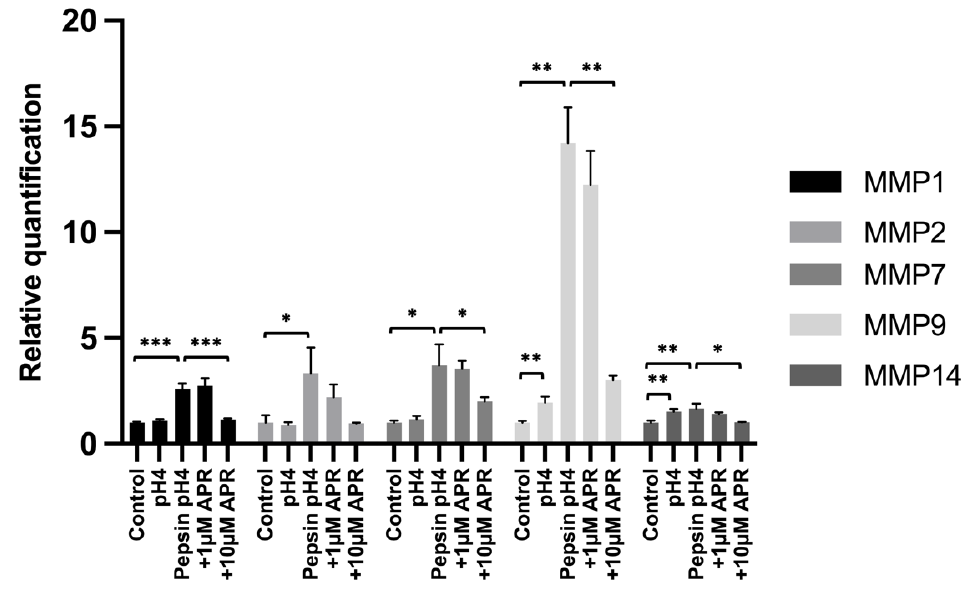
Figure 3. Expression of MMPs following mock treatment, treatment with acidified pepsin ±1 or 10 µM amprenavir, or acid alone. Where significant, the following comparisons are shown: control vs. pH4, control vs. pepsin pH4, pepsin pH4 vs. +1 µM APR, and pepsin pH4 vs. +10 µM APR. * = p < 0.05, ** = p < 0.01, *** = p < 0.001.